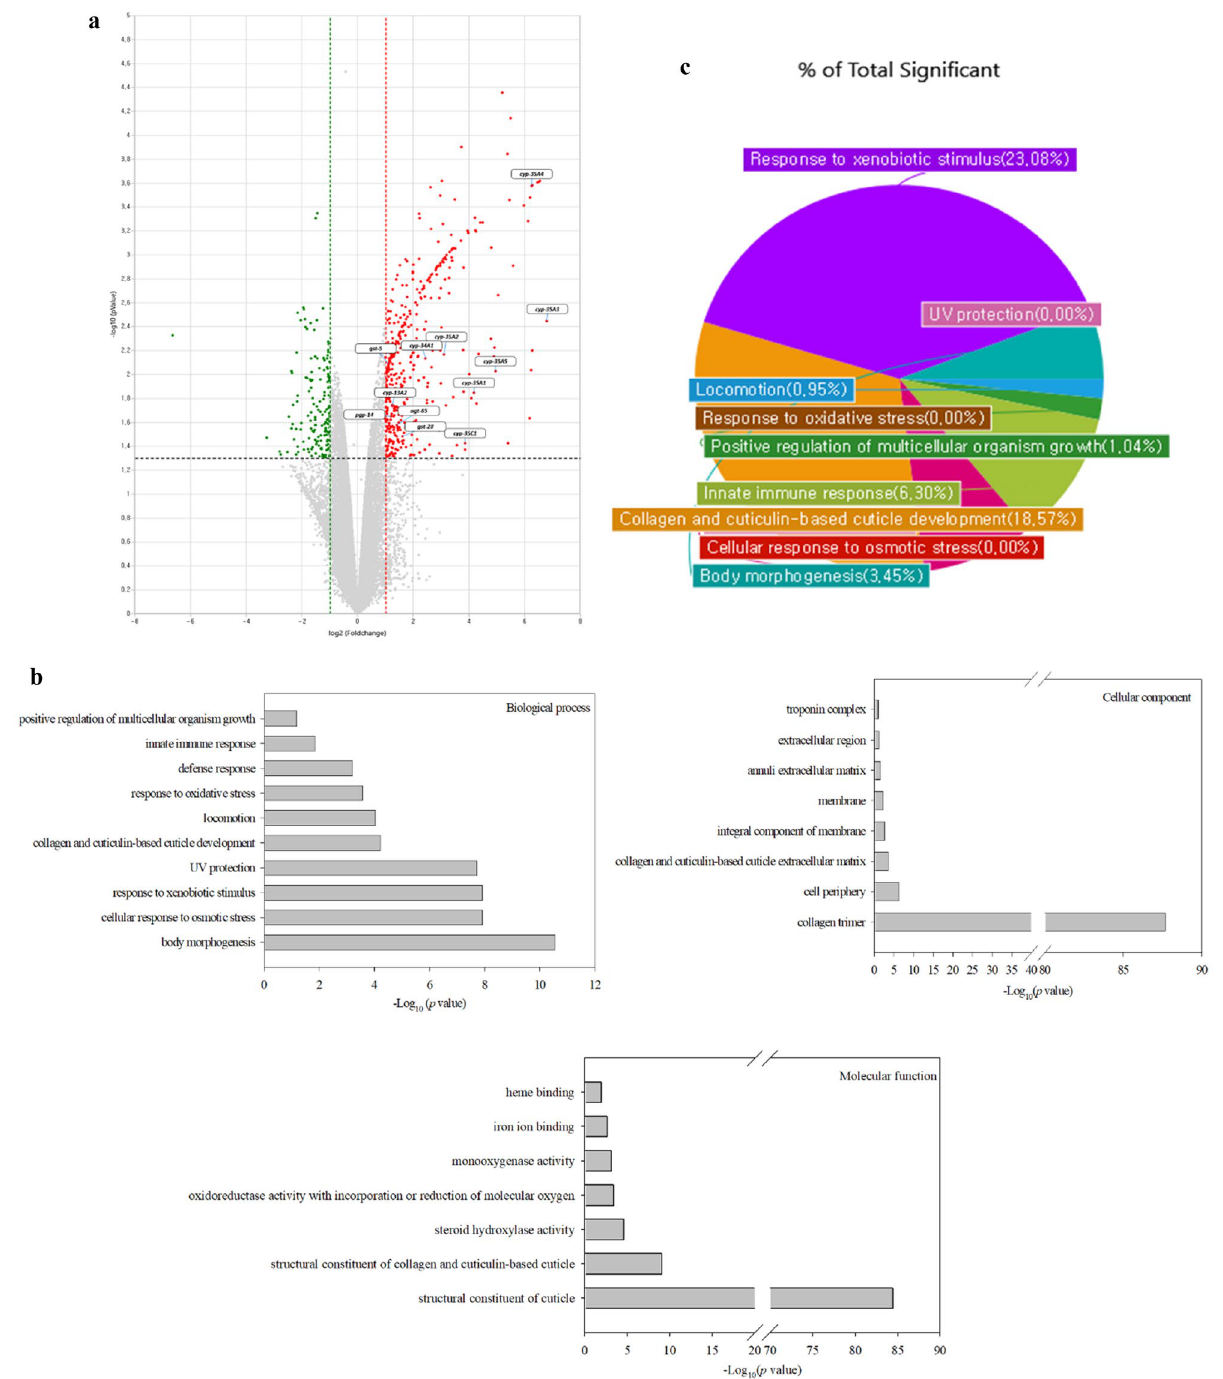
Figure 3. Differential gene expression between the negative control and 200 µM remofuscin-treated groups as determined by RNA microarray analysis. DEG analysis software (ExDEGA v.1.6.8, Ebiogen, KOR) was used to display the gene expression data as a volcano plot ( A ). The genes in the boxes are related to xenobiotic detoxification shown in Supplementary Table S1 (fold change ≥ 2.0 and p < 0.05). The DAVID functional annotation tool was used to analyze the gene ontology terms ( B ), and the biological processes associated with the DEGs revealed by microarray analysis are shown as a pie chart ( C